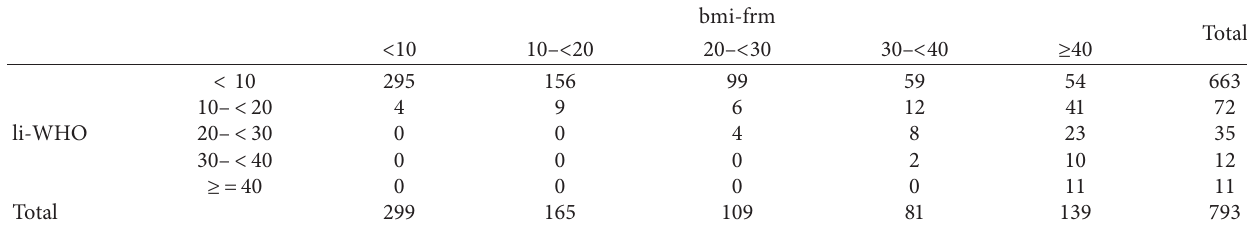
Table 4: Agreement between bmi-Frm and li-WHO-based prediction tool in a sample of 793 consecutive outpatients in the cardiology unit of the